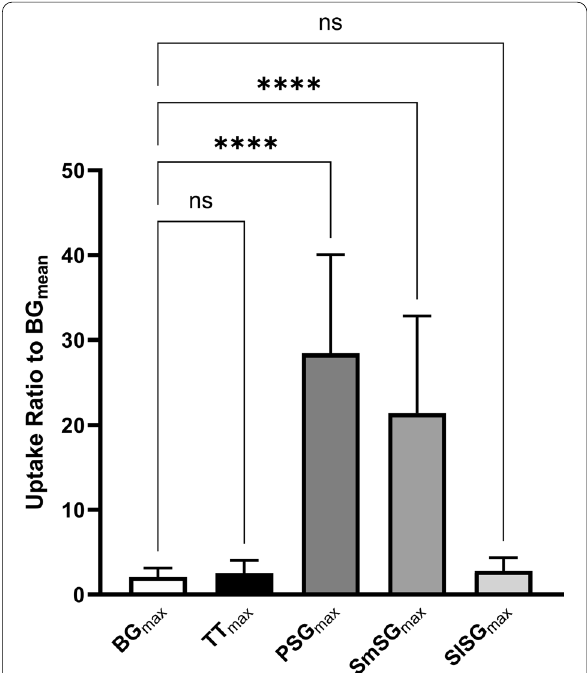
Fig. 2 Ratios of maximal counts of [ 99m Tc]pertechnetate in each salivary gland and the background to mean counts of the background. BG background, TT torus tubarius, PSG parotid salivary